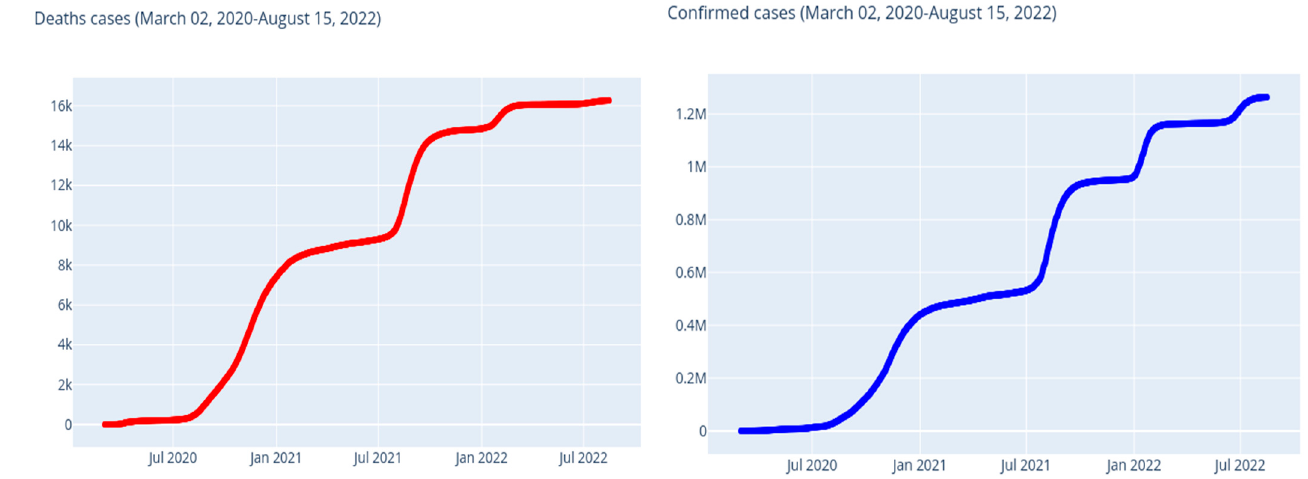
Figure 6. Morocco: evolution of the number of confirmed cases and deaths by SARS-CoV-2.